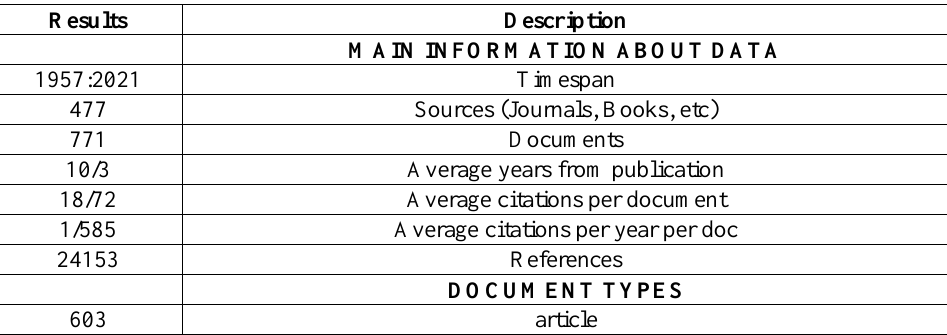
Table 1. Descriptive statistics of